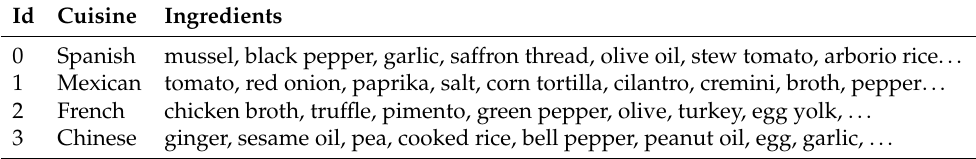
Table 1. Labelled Recipe Data